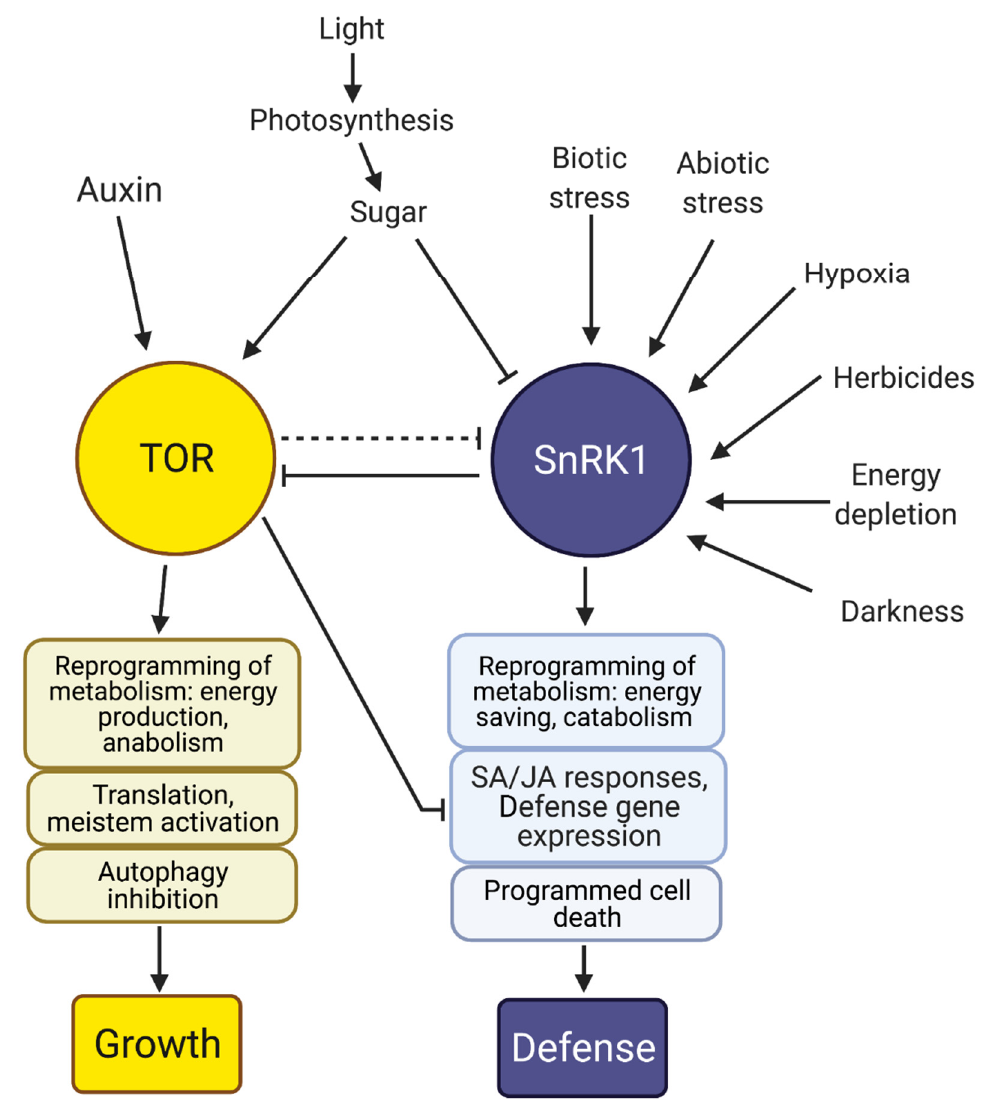
Figure 3. A simplified model of SnRK1-TOR growth–defence regulation. Kinases Sucrose nonfermenting 1 (Snf1)-related kinase (SnRK1) and target of ramamycin (TOR) are master regulators which sense energy status and work antagonistically to reprogramme metabolism through phosphorylation of diverse targets. TOR is active in nutrient-rich conditions to promote translation and growth while inhibiting autophagy. SnRK1 is activated in times of energy depletion often caused by stress, operates to promote defence responses, and suppresses growth. SnRK1 phosphorylates and inactivates TOR directly to limit growth and promote autophagy. TOR inhibits SnRK1 outputs indirectly. Solid lines indicate direct interactions, dashed lines indicate indirect